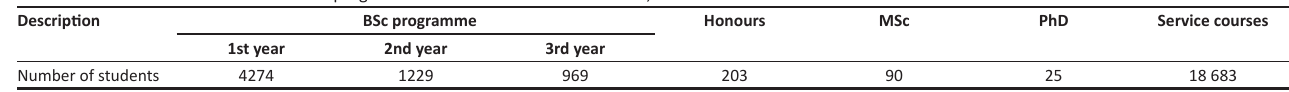
TABLE 1: Number of students in Statistics programmes at South African universities, 2006.